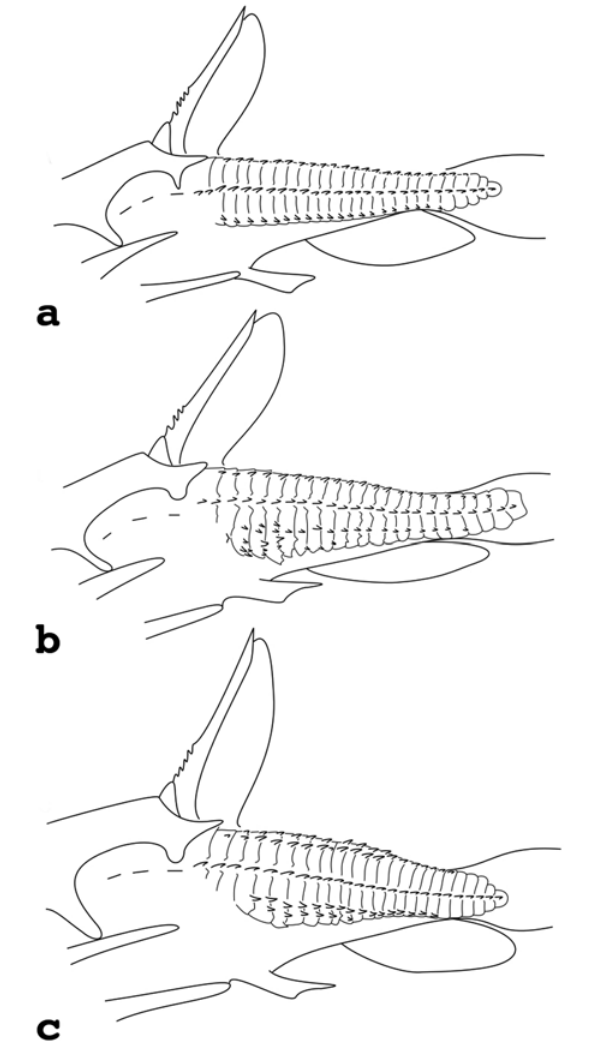
Fig. 9. Physopyxis ananas . Diagram of three different types of lateral plate ornamentation: a. MPEG 7189 Caxiuanã, 15.21 mm SL; b. ANSP 177256. Essequibo River, 17.50 mm SL; c. MPEG 7189, Caxiuanã, 16.53 mm